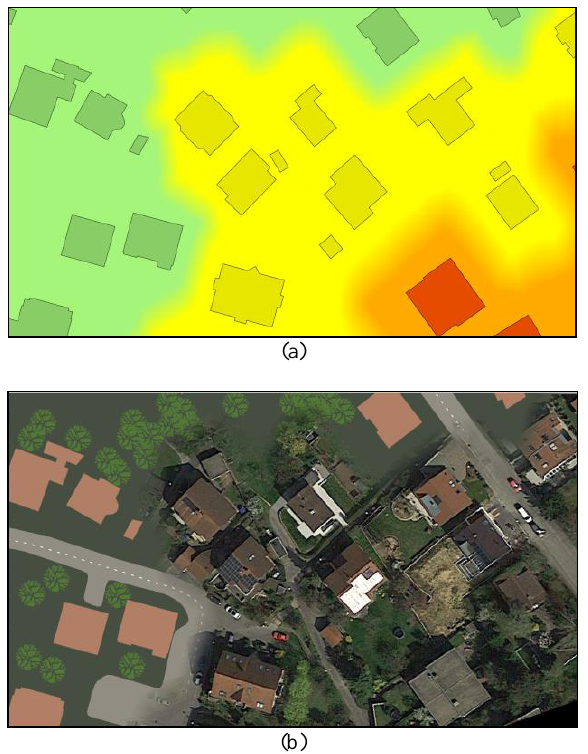
Figure 5. A conceptual privacy map with a smooth transition between three anonymity levels (a), final privacy map with corresponding blended representations between map and image (© Google) (b). A corresponding 3D scene using the generated 2D privacy map as its background is shown in Figure 6.